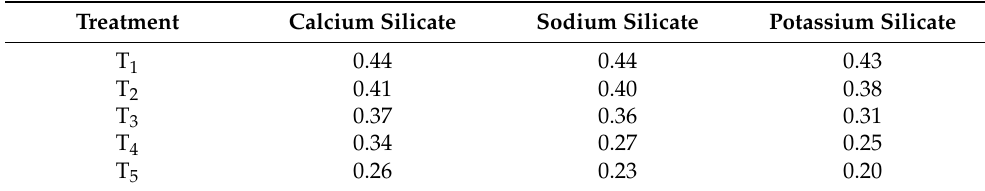
Table 4. Effect of silicate chemicals, with various doses of foliar applications, on the HRI of rice grown in Cd-contaminated